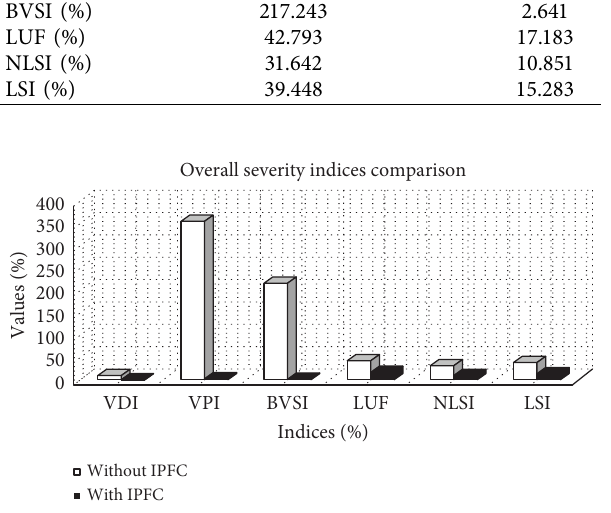
Figure 5: Overall severity indices comparison for a severe N-1 contingency